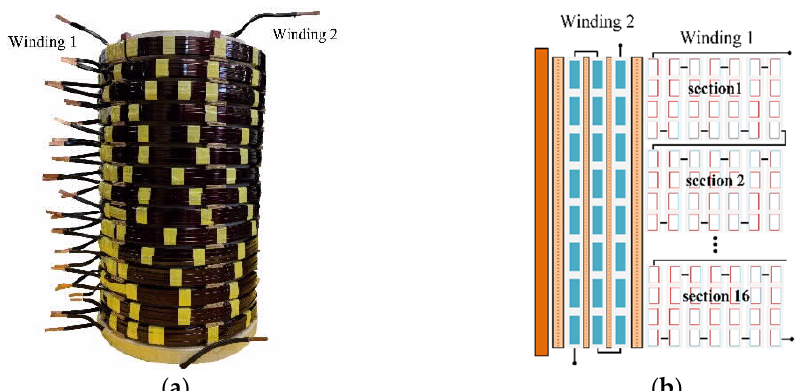
Figure 1. Laboratory winding model used for FRA tests: ( a ) photo and ( b ) connection schematic.